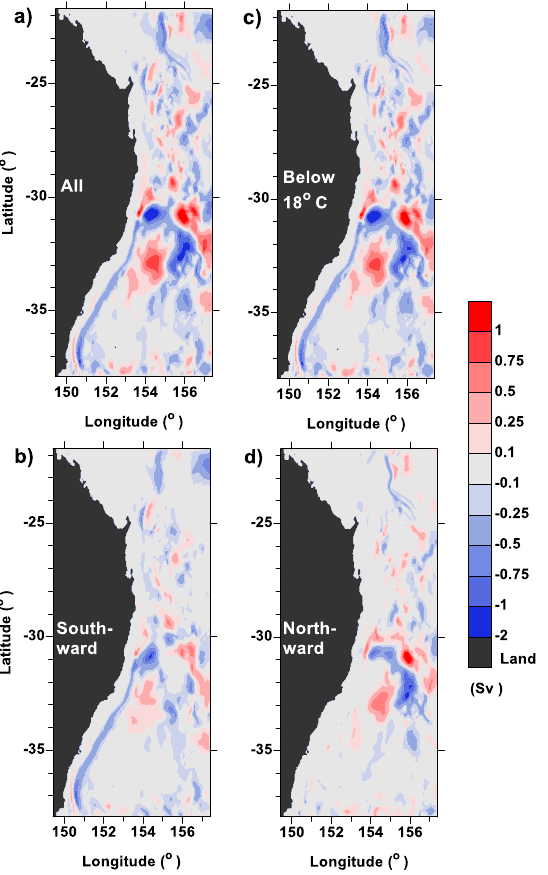
Fig. 5 Differences in the mean barotropic North–South transports a for all flow, b for southward flows, c for flow of waters 18 °C or below, and d) for northward flows Fig. 6 a Time series of the elevation at 30° S 154° 11’E indicating the